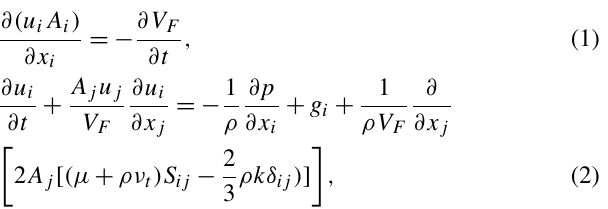
Figure 5. Wave surface evolutions for stationary and moving cylin- ders, H i = 0.05m.